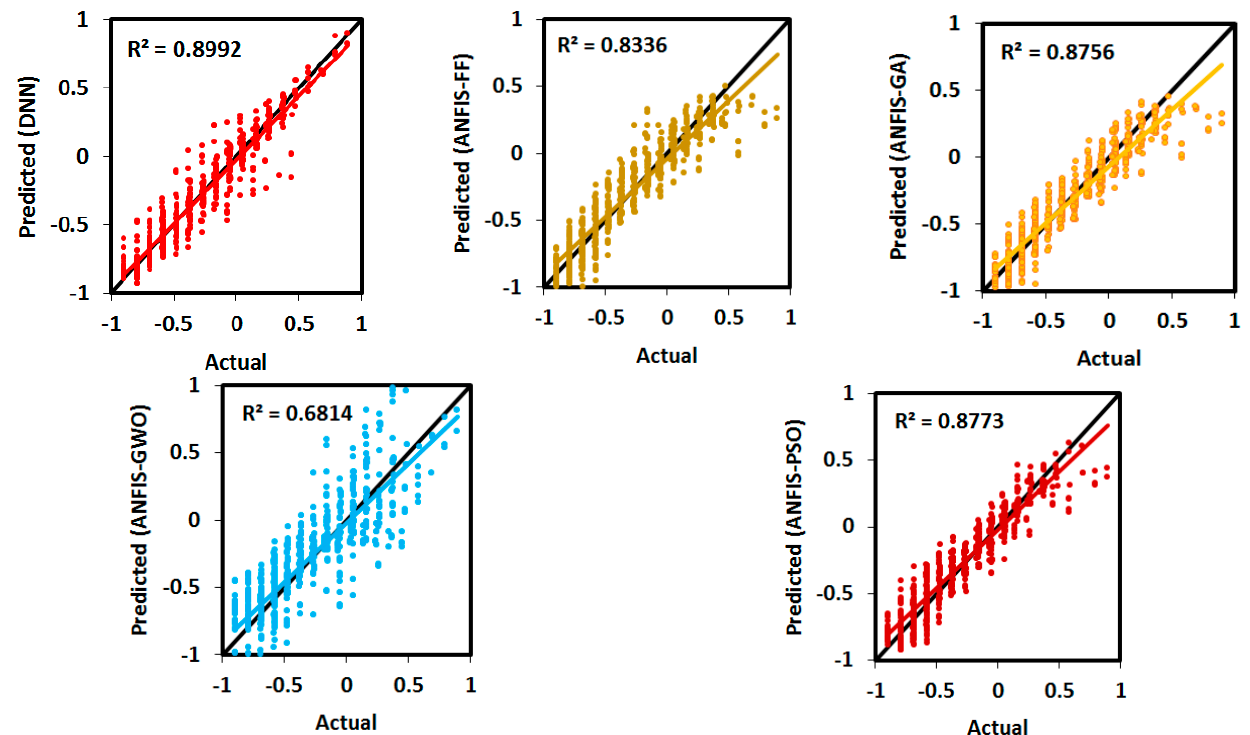
Figure 8. Illustration of actual and predicted strain in lateral ( x ) dimension (Training phase).